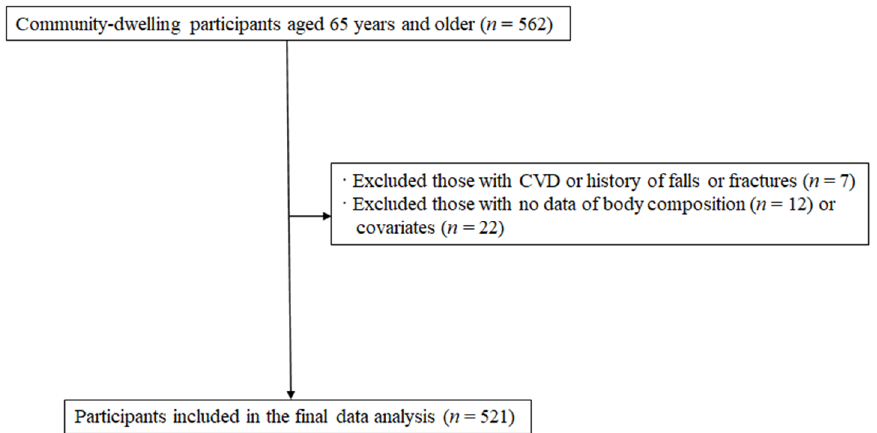
Figure 1. Flowchart of the study participants.